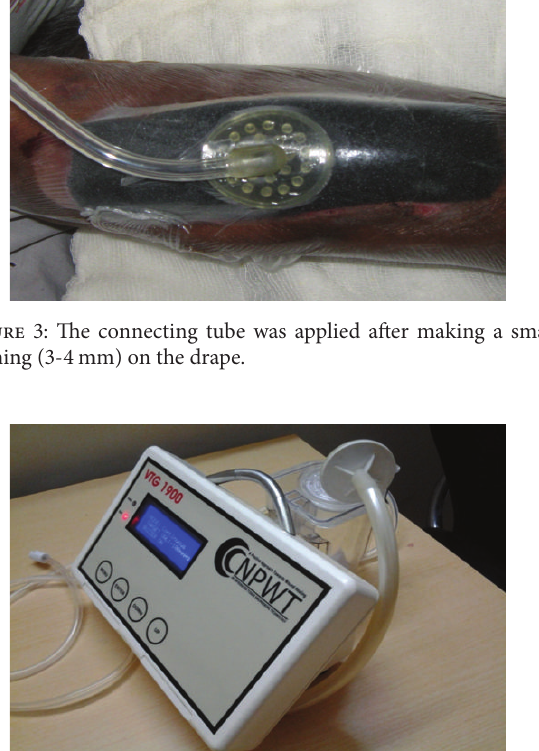
Table 1: Decrease in wound size from day 0 to day